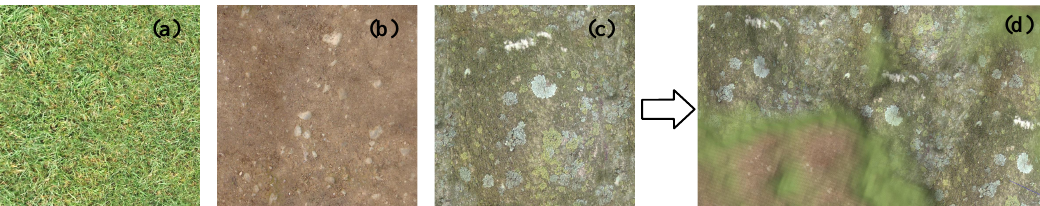
Figure 7. The textures of grass ( a ), sands ( b ), and rocks ( c ) were captured in the real world. By applying suitable height maps, we can fuse all the textures into a whole mixed terrain scene. The fade-in and fade-out fusion was used to eliminate the image stitching seams. Sunlight conditions also applied to make synthesized data more realistic. Top view of the final synthesized scene are shown in ( d